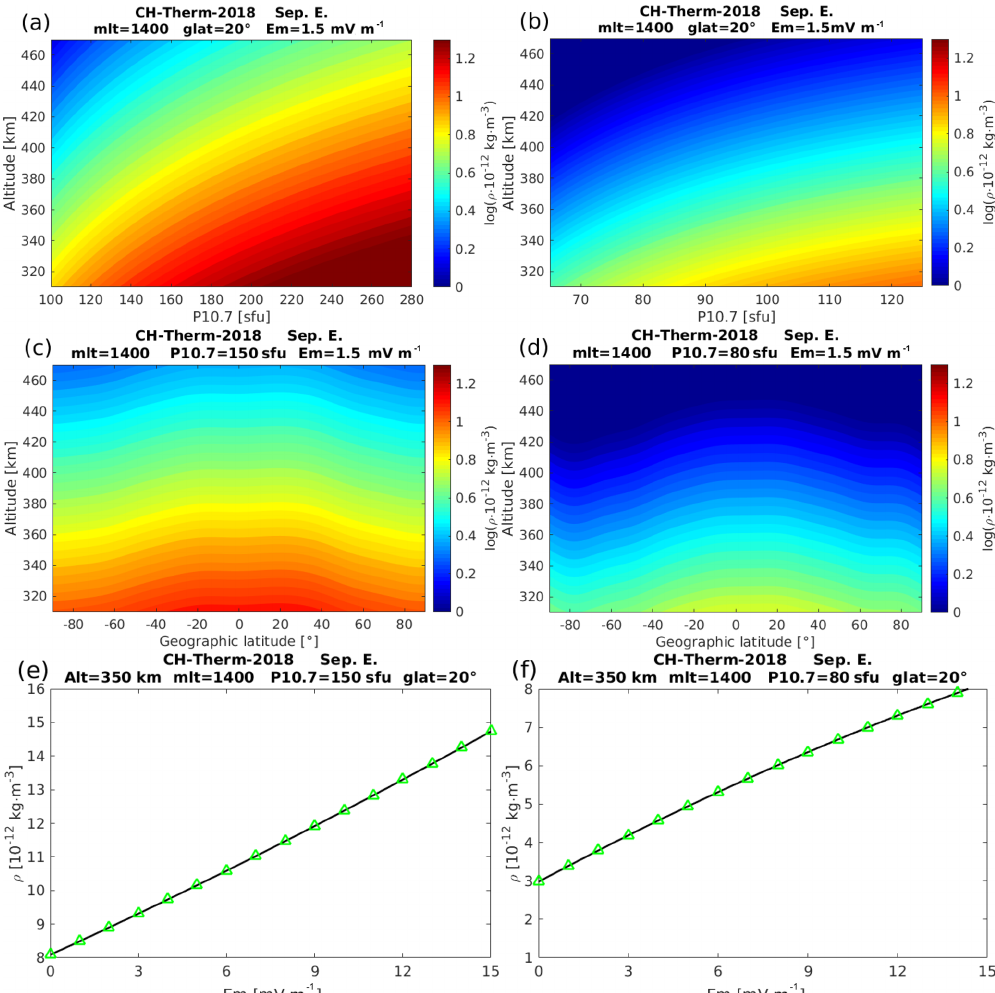
Figure 3. The altitude versus solar activity variations of model-predicted thermospheric mass density around noon at (a) high and (b) low solar activity conditions. The longitude has been chosen at Greenwich meridian. Panels (c) and (d) are the altitude versus geographic latitude variations of model-predicted mass density for high and low solar activity conditions, respectively. Panels (e) and (f) show the dependence of model-predicted mass density on merging electric field for both